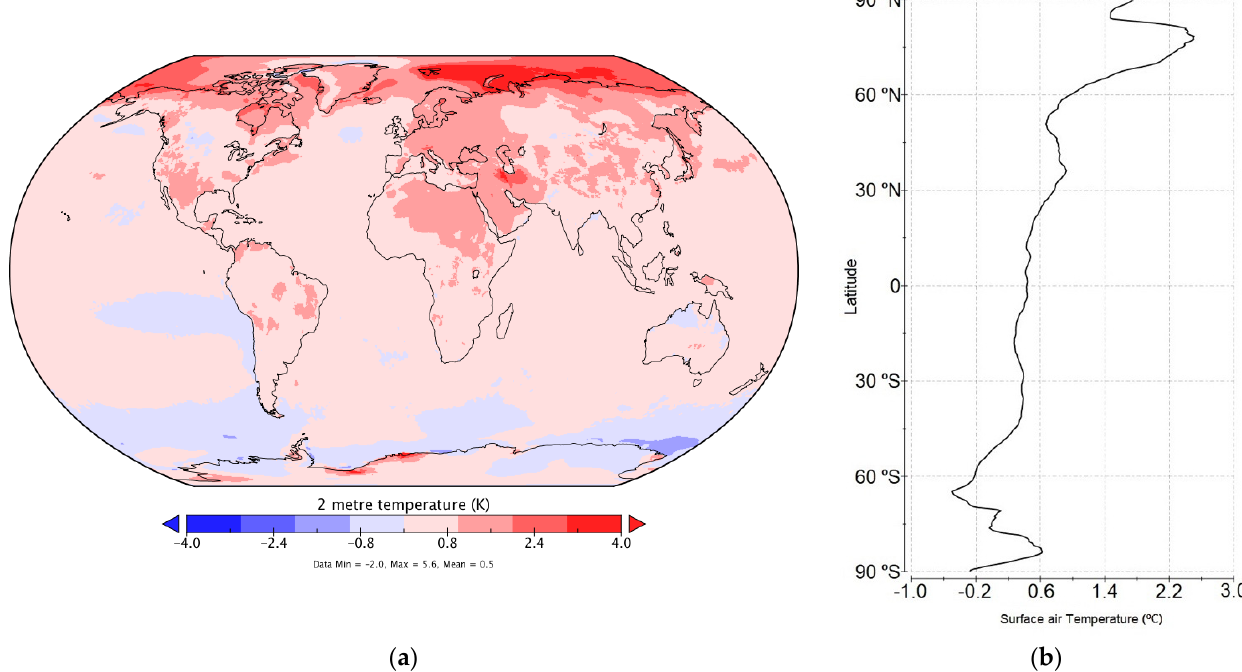
Figure 2. ( a ) Global map of the polar amplification measure obtained from long-term observations of the near-surface air temperature (°C) for the 2010–2020 period relative to the 1980–1990 period. ( b ) Zonal mean of the near-surface temperature (°C) for the 2010–2020 period relative to the 1980–1990 period.